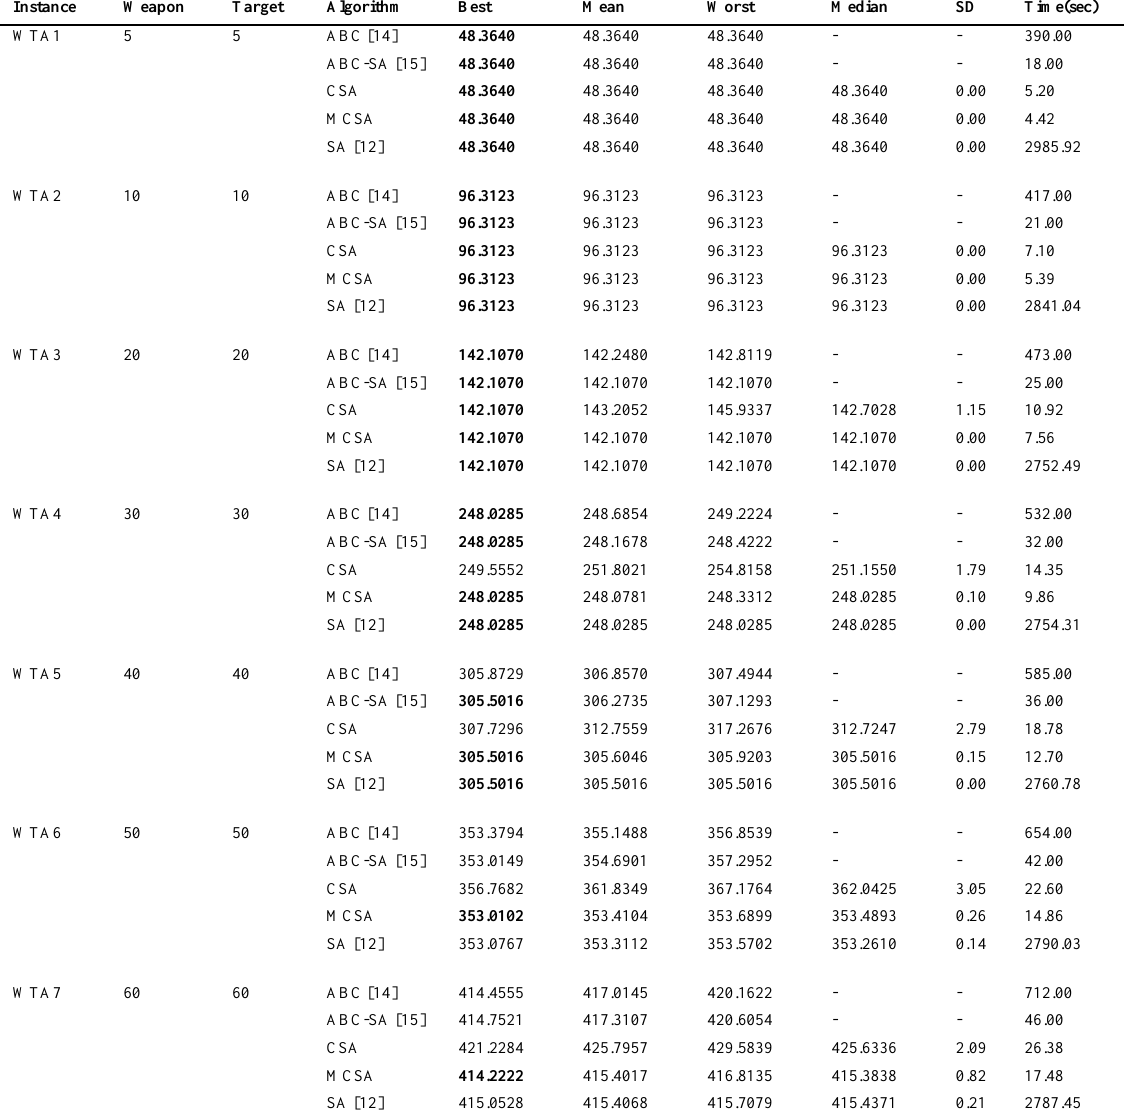
Table 4. Comparison with the state-of-the-art algorithms on the problem